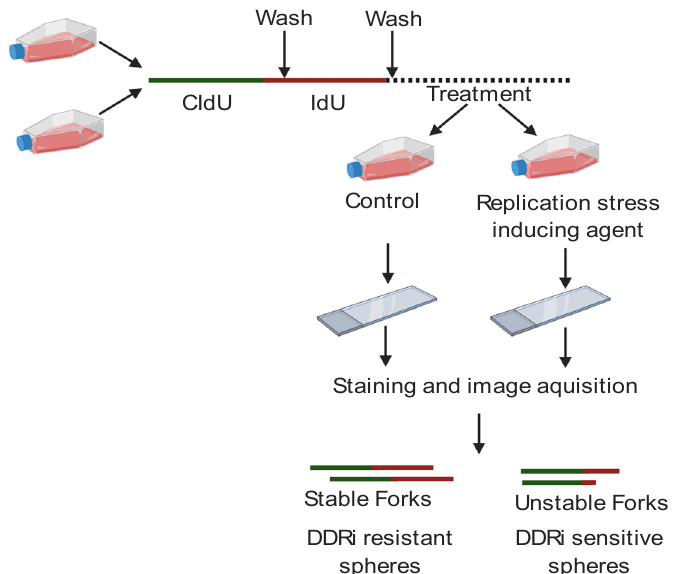
Figure 3. Schematic of DNA fiber technique. Cells are sequentially pulsed with the nucleotide analogs CldU and IdU and then treated with a replication stress inducing agent such as hydroxyurea. Cells are lysed, the DNA fibers are linearly arrayed on cover slips and stained with fluorescently tagged antibodies, and the fibers are visualized and counted. The ratio of the green first track to the red second track is calculated for each fiber. Tumor cells with stable forks that are more likely resistant to DDR inhibitors (DDRi) have a ratio of one while tumor cells with unstable forks have a ratio less than one and are more likely sensitive to DDRi.